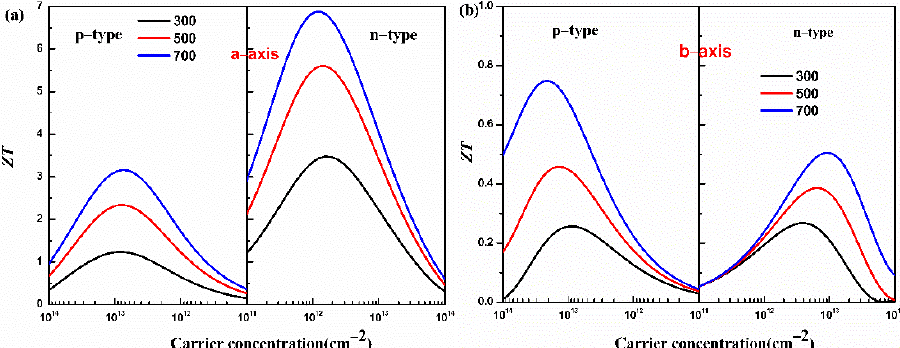
Figure 6. Calculated figure of merit ZT of the monolayer Hf 2 Br 4 along the a-axis ( a ) and b-axis ( b ) for the p- and n-types as a function of carrier concentration at 300, 500 and 700 K.